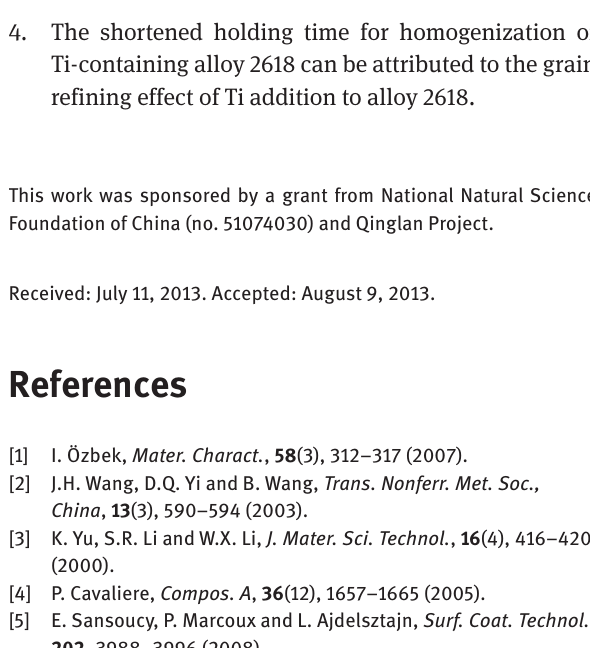
Fig. 6: Line-scan analysis of Ti-containing alloy 2618 before and after homogenization: (a) As cast alloy; (b) The alloy homogenized at 773 K for 12